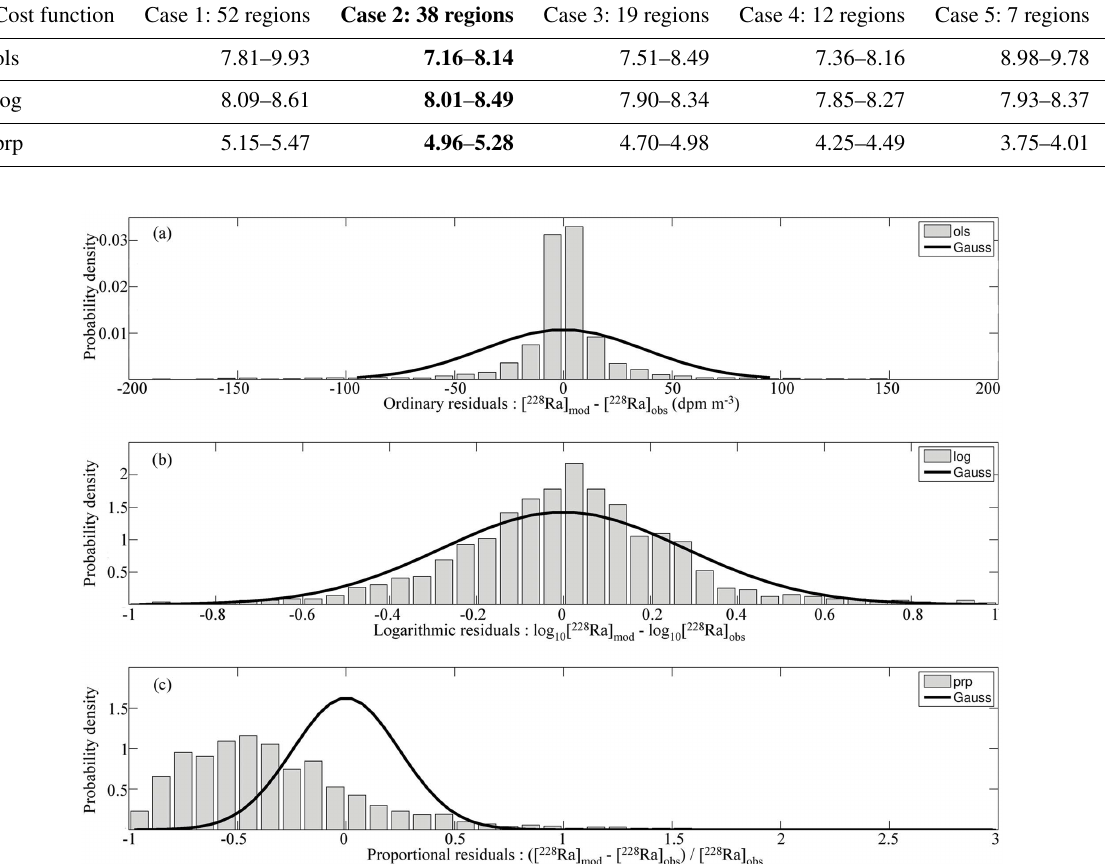
were merged to define the 38 standard regions of this